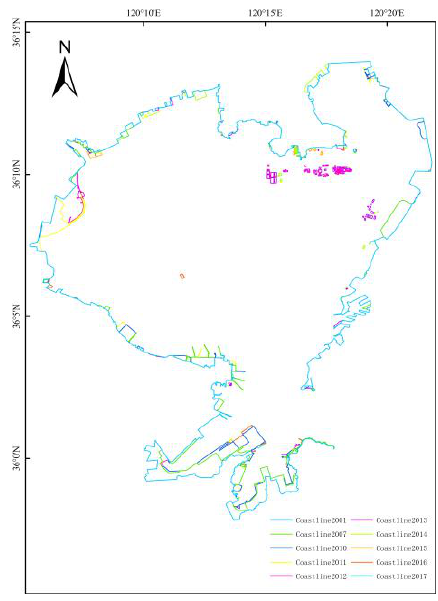
Figure 3 Jiaozhou Bay Coastline